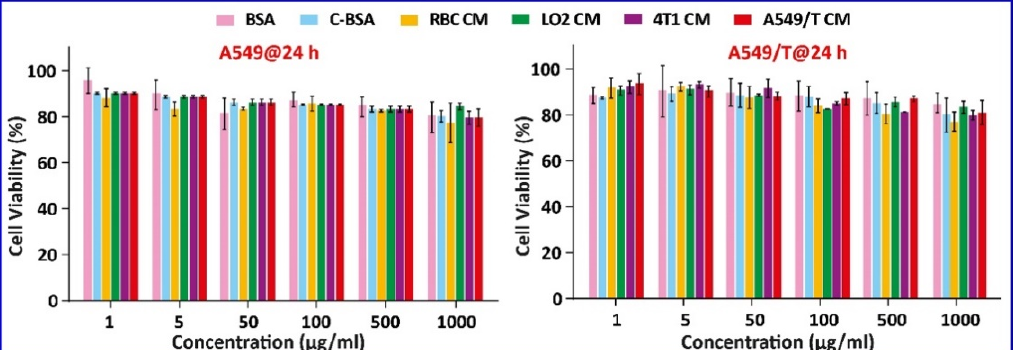
Figure 2. Isolation, preparation, particle size, and PDI of cell membrane vesicles. ( A ) Red blood cells (RBCs), ( B ) LO2, ( C ) 4T1, and ( D ) A549 / T.